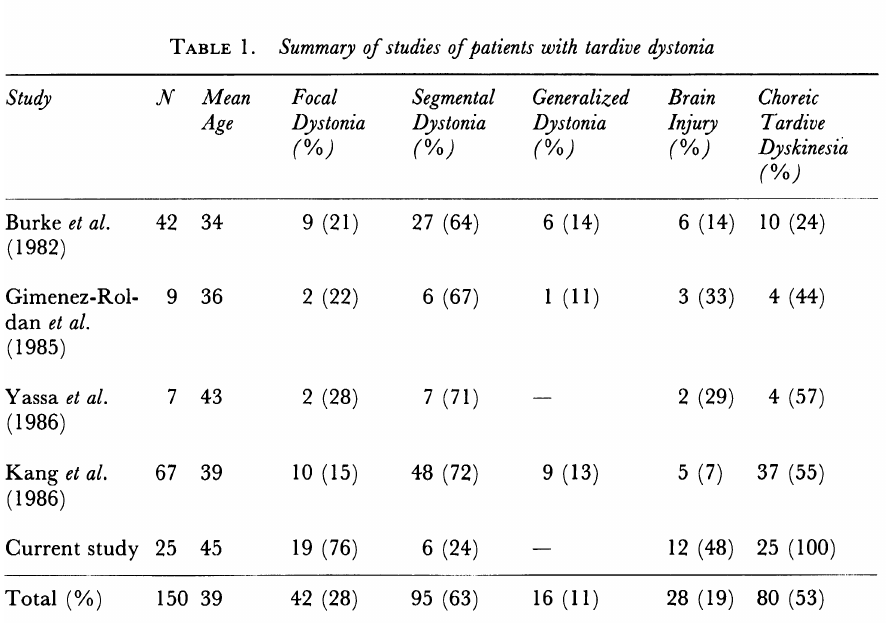
TABLE I, Summary of studies of patients with tardive